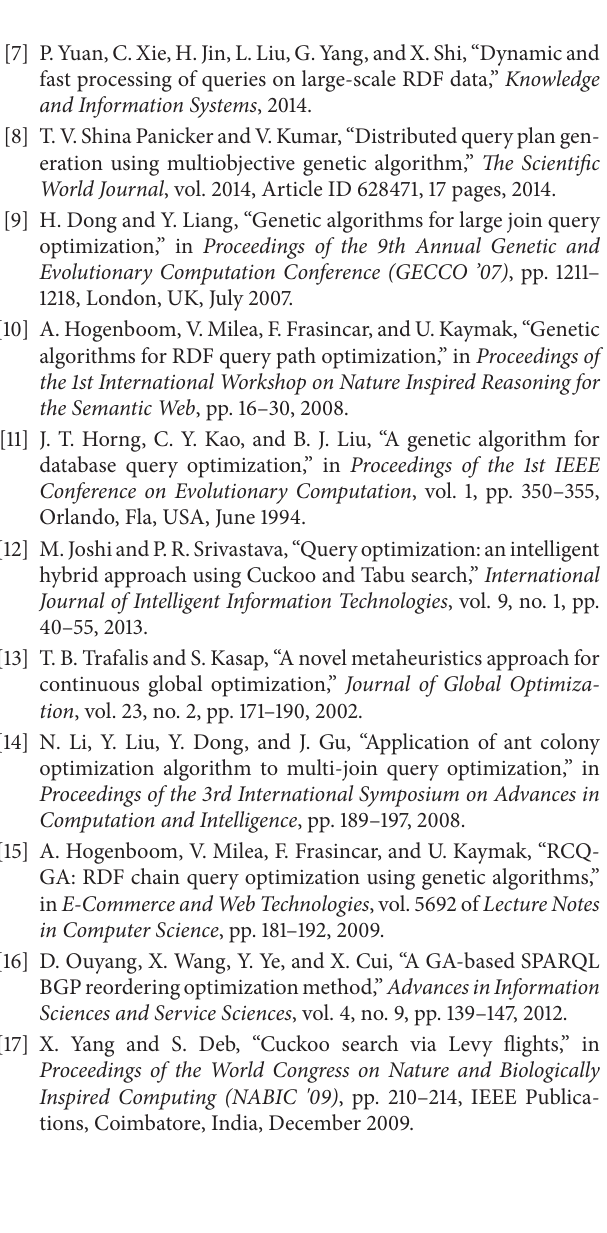
recorded for diverse dataset sizes. To improve the accuracy of the work, Cuckoo search algorithm can be hybrid with other swarm algorithms in the future and performance can be